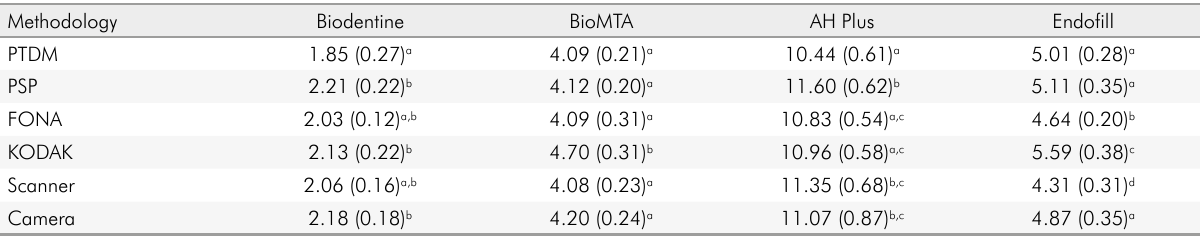
Table 3. Radiopacity (mean and SD) calculated with the quadratic model in mm Al, comparing grayscale values (converted to absorbance) of the methodologies used with the ODU values of the